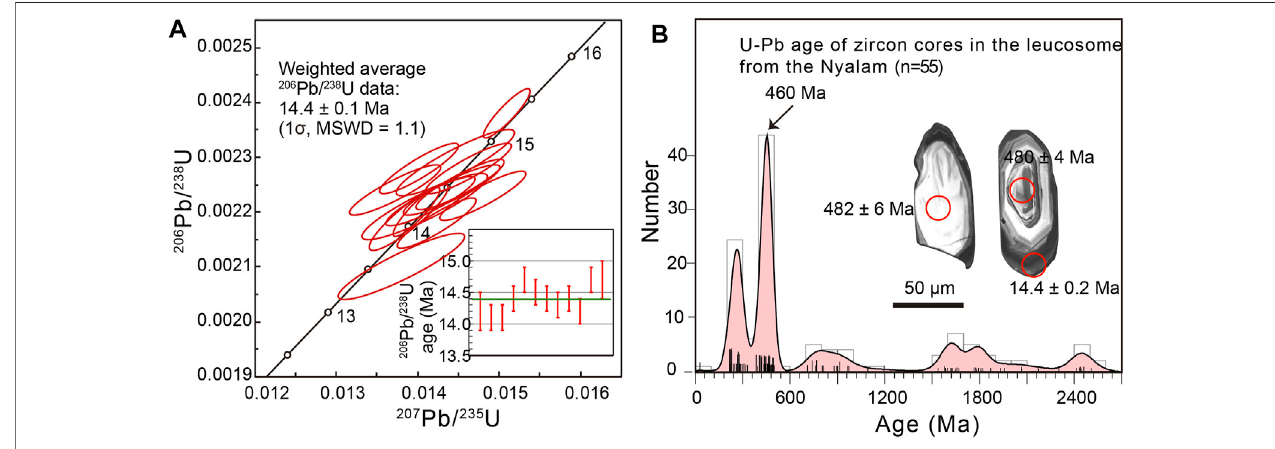
FIGURE4|(A) TheU – (Th) – Pb dating ofzircon rims in theleucosome (B) Thekerneldensity estimates ofzircon cores 207 Pb/ 235 U ages in theleucosome. Inserted images show the represented zircons from the leucosome. The red circle is the laser spot. The data are listed in Supplementary Table S3